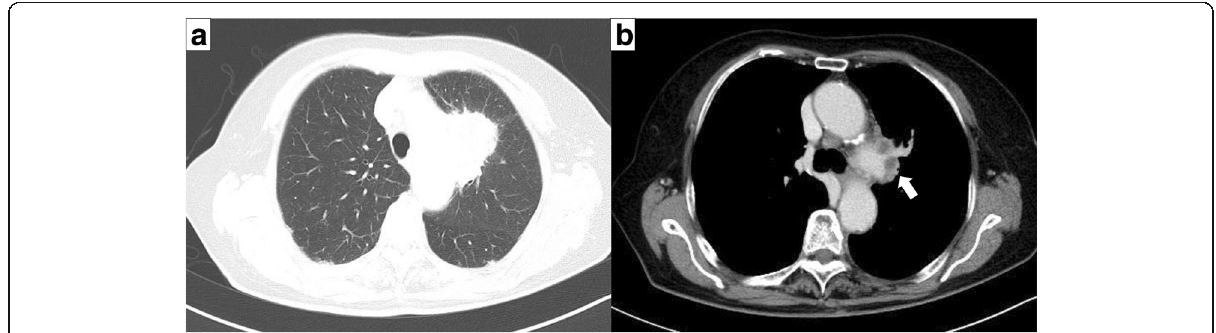
Fig. 1 Preoperative chest computed tomography (CT) scan. a Chest CT scan showing a 5 cm tumor in the left upper lobe . b Tumor was suspected to invade the pulmonary artery ( arrow